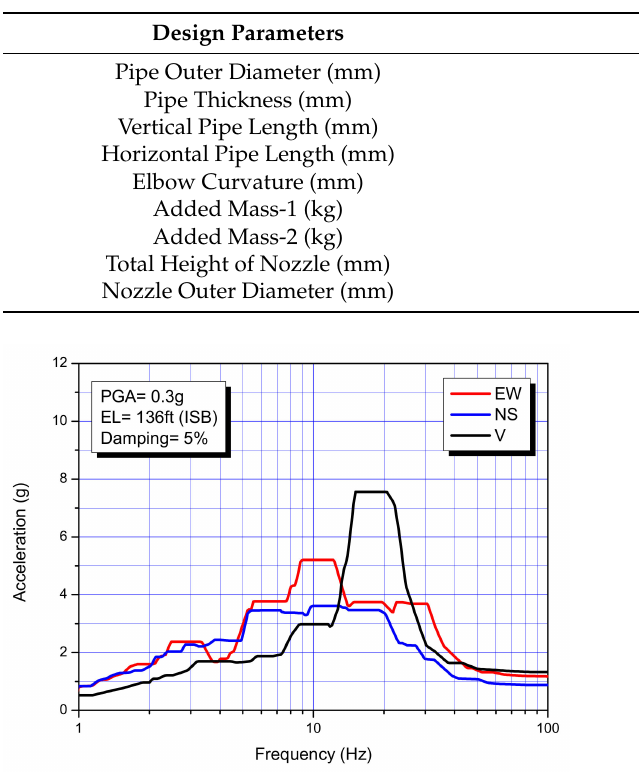
Figure 1. Overall configuration of the test mockup and seismic directional axis. Table 1. Summary of test mockup design parameters.